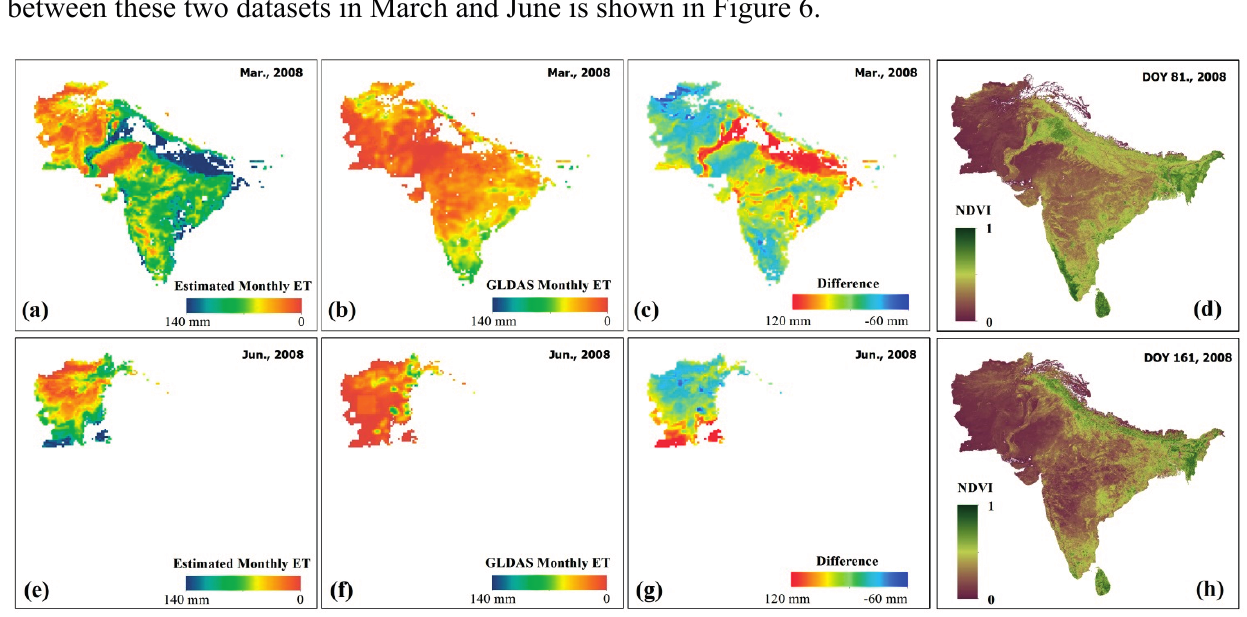
Figure 6. Monthly ET difference between the estimation result and the GLDAS product in March and June 2008. ( a ) presents the estimated monthly ET, ( b ) presents the GLDAS monthly ET product, ( c ) shows their difference in March, and ( d ) shows the NDVI spatial distribution of day of year (DOY) 81, 2008. ( e ) presents the estimated monthly ET, ( f ) presents the GLDAS monthly ET product, ( g ) shows their difference in June, and ( h ) shows the NDVI spatial distribution of DOY 161,